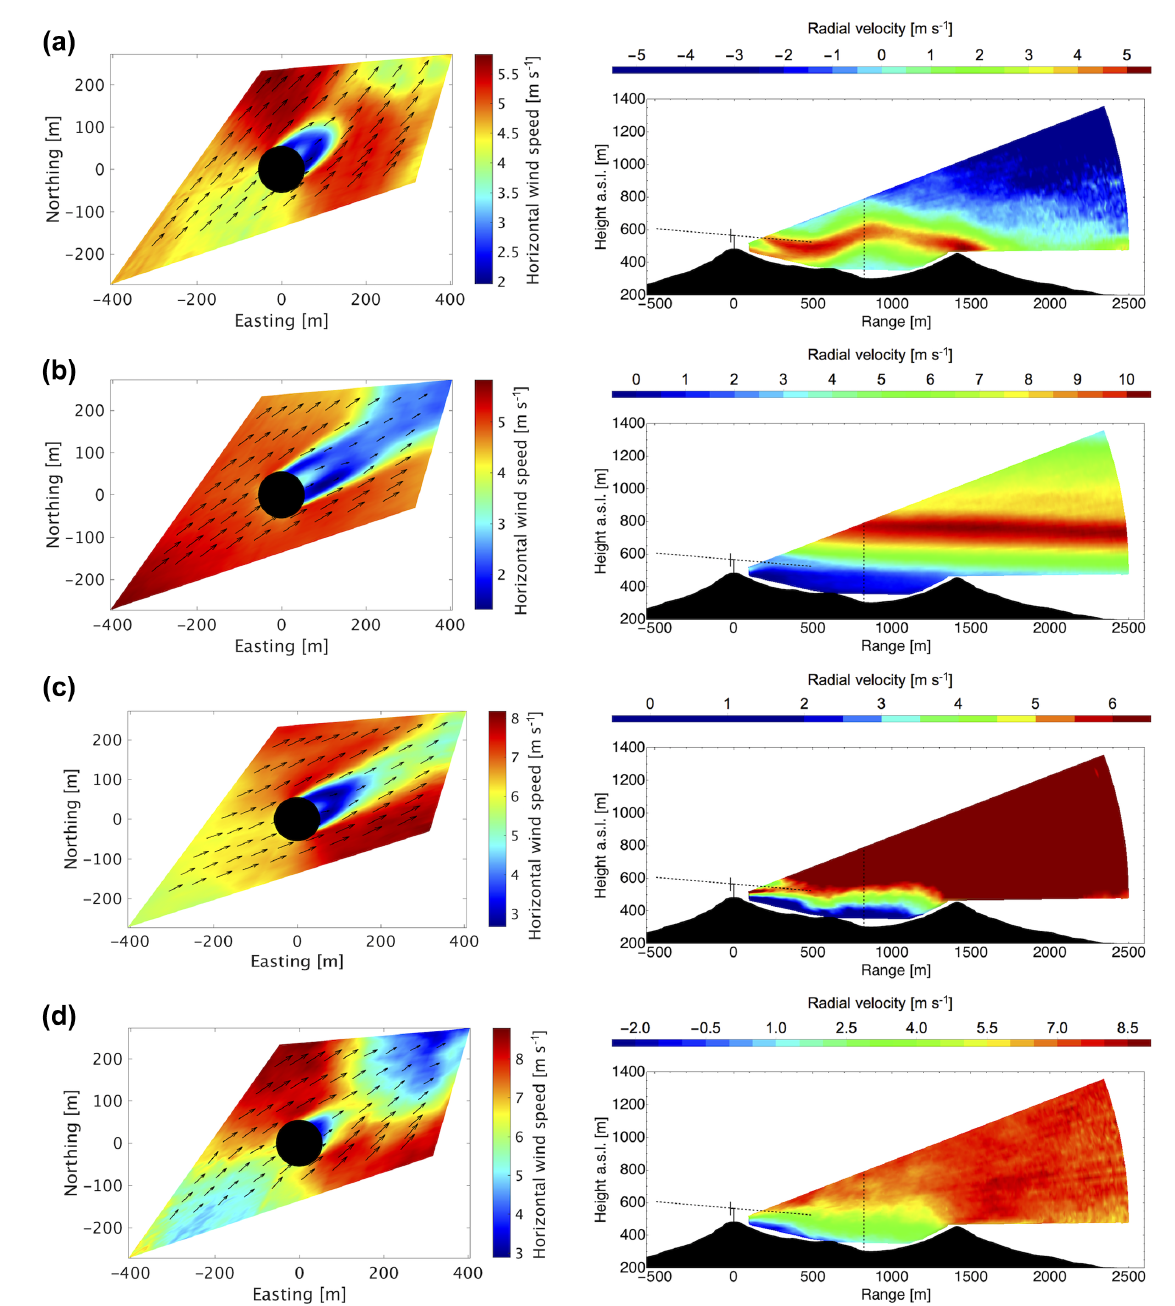
Figure 9. Observed wake cases with the diamond scan (left) and transect scan (right). (a) Downwards-displaced wake, stable atmospheric conditions + atmospheric wave; (b) no displacement, stable atmospheric conditions; (c) no displacement, neutral atmospheric conditions; (d) upwards-displaced wake, unstable atmospheric conditions (measurements of example periods taken (a) 02:52–03:02UTC, 9 June 2015, (b) 06:18–06:28UTC, 7 June 2015, (c) 22:20–22:30UTC, 10 June 2015, (d) 11:16–11:26UTC, 10 June